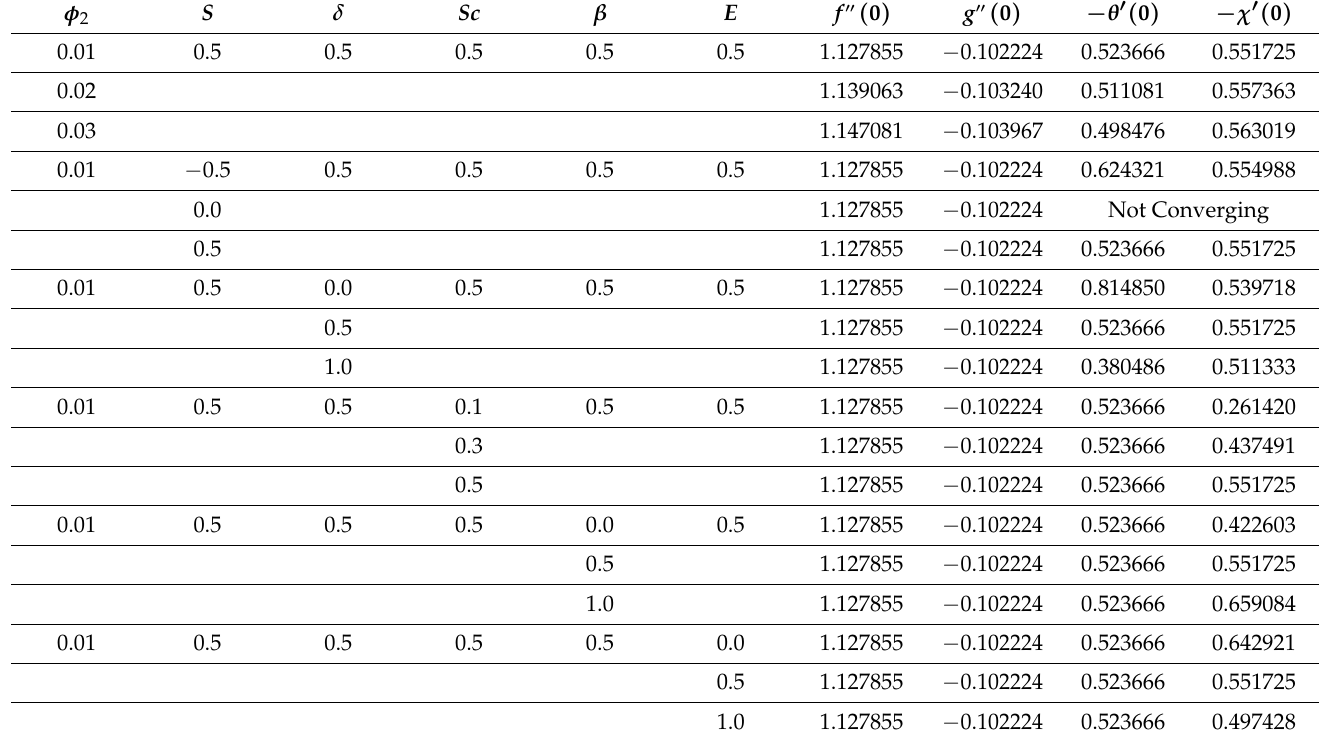
Table 5. For saddle point, computational values of f (cid:48)(cid:48) ( 0 ) , g (cid:48)(cid:48) ( 0 ) , − θ (cid:48) ( 0 ) and − χ (cid:48) ( 0 ) with Pr = 6.2, n = 0.2, α = 0.5 and φ 1 =